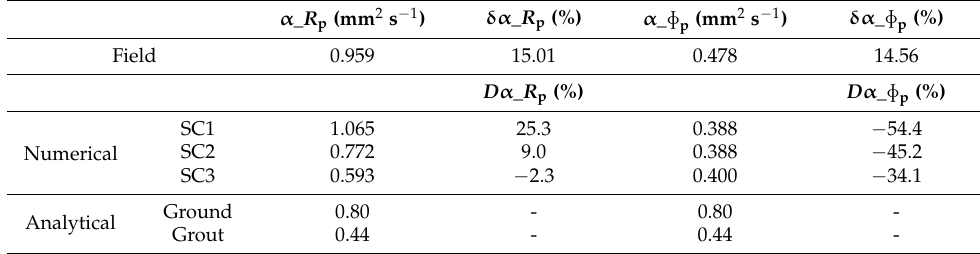
Table 10. Comparison of thermal diffusivity obtained from the analysis of field tests and numerical simulations. TD of ground and grout are also reported.